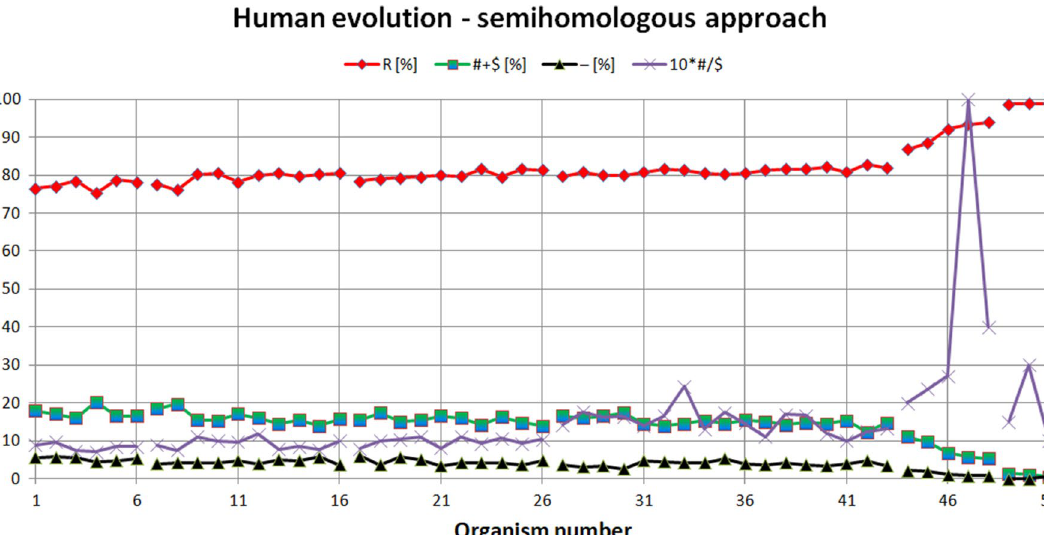
Figure 2. Human evolution examined using semihomologous approach. The organisms presented on the X-axis are set in the order determined by the neural network from the organism most evolutionarily distant from Homo sapiens (organism number 1 on the X-axis, i.e. Tupaia belangeri ), to the organism closest to human (organism number 51 on the X-axis, i.e. Homo heidelbergensis ). "R"—homologous positions, "# + $"— semihomologous positions (sum of positions with transitions and transversions), "−"—positions with two or three point mutations, "#/$" factor—ratio # to